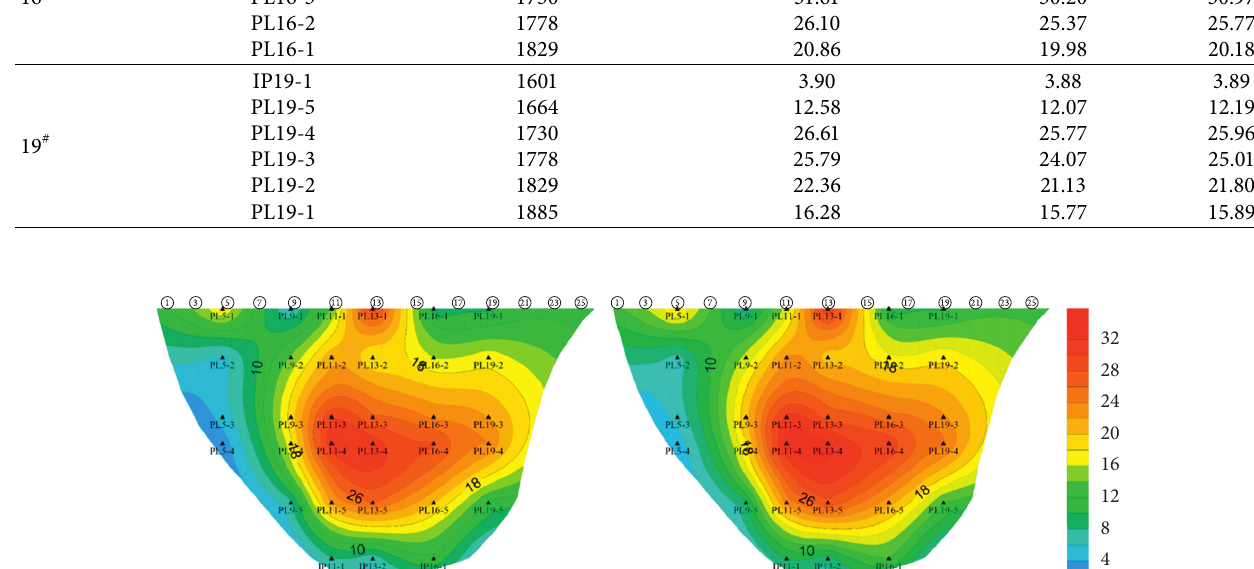
Figure 7: The nephogram comparison between the calculated (QGA) displacement values and the measured values under 1858.34 m.